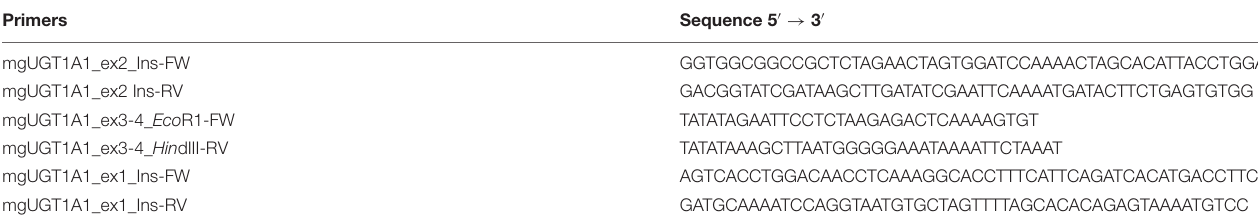
TABLE 1 | Primers for insert amplifications. Primers